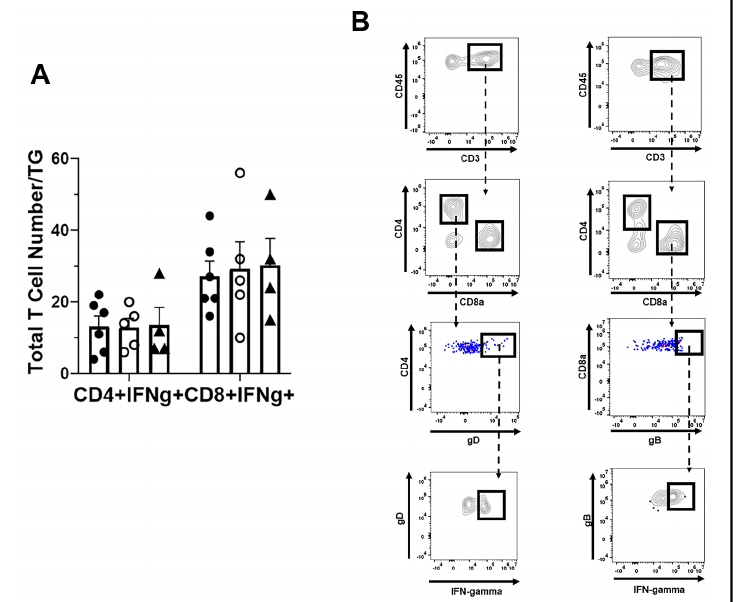
Figure 8. T cell function in the TG of WT, TRIM21+/ − and TRIM21 KO mice, at day 7 post infection. Male and female C57BL/6 (WT), TRIM21+/ − , and TRIM21 KO mice (n = 5–6/group) were infected with HSV-1 (10 3 PFU/cornea). ( A ) At day 7 pi, the mice were exsanguinated, and the TG were processed to single cell suspensions and cultured for 6 h in the presence of PMA and ionomycin in the presence of brefeldin. Following these culture conditions, the cells were washed and stained for IFN- γ expressing HSV-1 gD-specific CD4+ and gB-specific CD8+ T cells and analyzed by flow cytometry. The results are summarized, with the bars representing the mean + SEM. No IFN- γ expressing cells were noted in unstimulated cultures. ( B ) Gating strategy in the identification of cell populations acquired for panel A.